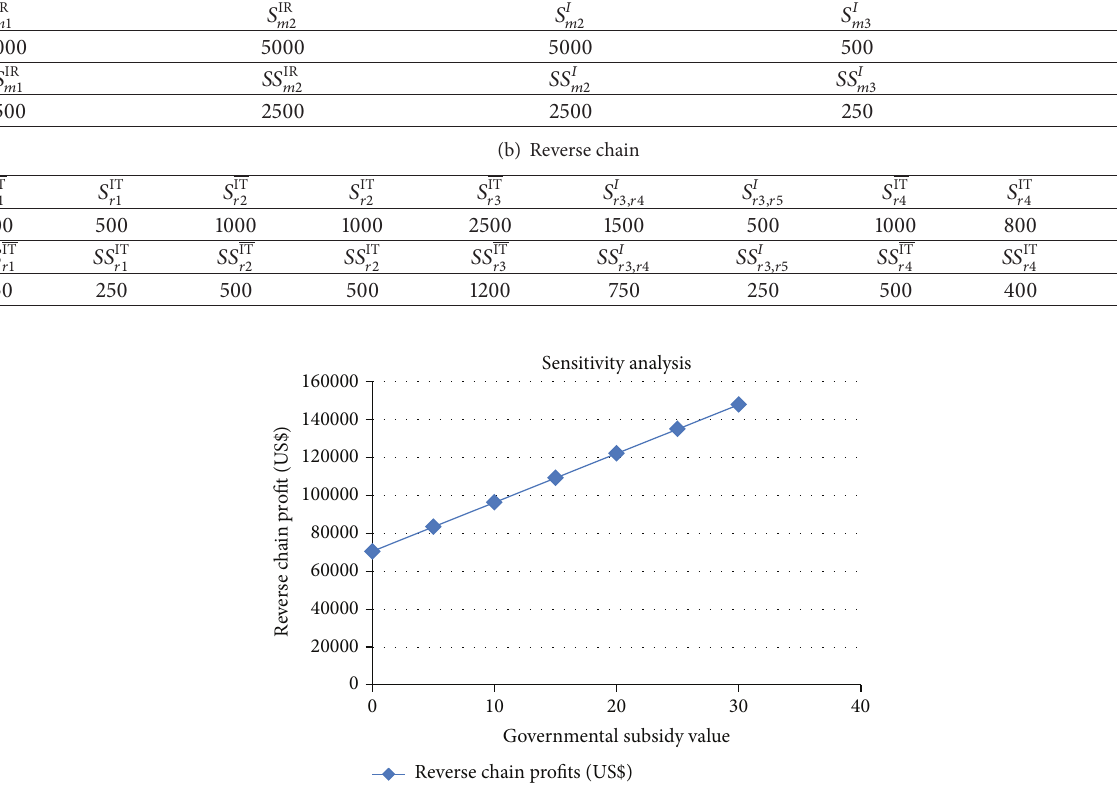
Figure 2: Numerical result of sensitivity analysis.